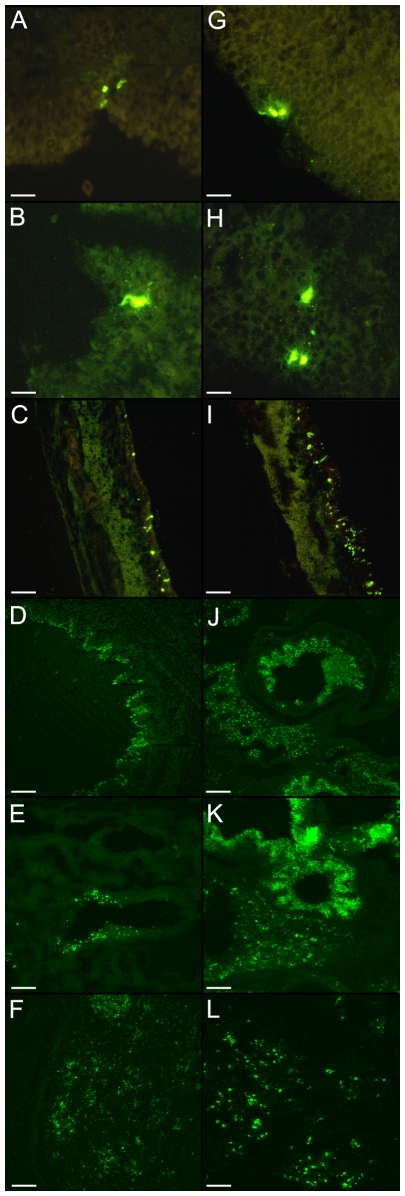
Viral antigen distribution of Ck/B/99 (left column) and Sw/B/98 (right column) throughout the porcine respiratory tract.The figure shows antigen positive cells in the respiratory (A,G) and olfactory part (B,H) of the nasal mucosa after intranasal inoculation, and in the trachea (C,I), bronchi (D,J), bronchioles (E,K) and alveoli (F,L) after intratracheal inoculation. Bars represent 12.5 µm (A,B,G,H), 25 µm (C,I,F,L) or 50 µm (D,E,J,K). Both viruses showed a similar distribution but the total number of positive sections was up to 100 times lower for the avian than for the swine virus. Positive sections also contained fewer positive cells with the avian virus, and we only show the sections with most antigen positive cells.